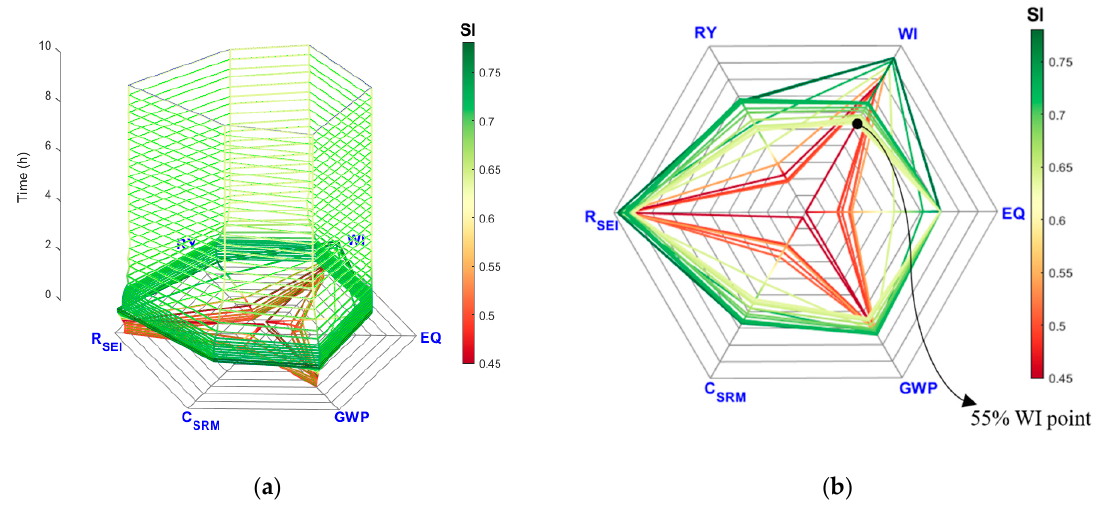
Figure 14. Case 2—dynamic sustainability performance with sustainability constraint: ( a ) 3D sustainability indicator dynamic radar plot; ( b ) 2D projection of sustainability indicator radar plot.